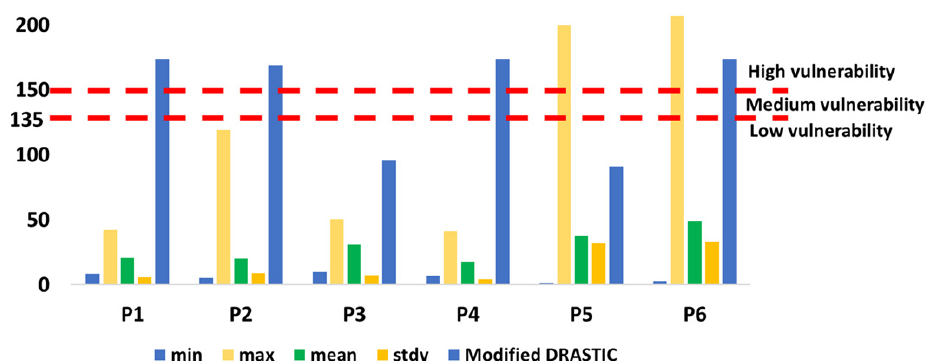
Figure 6. Electrical resistivity values (minimum, maximum, mean, standard deviation Ω .m) and modified DRASTIC Index. Maximum value of profile 5 (477.1 Ω .m) was set to (200) to maintain the scale within the limits of the perceived index.